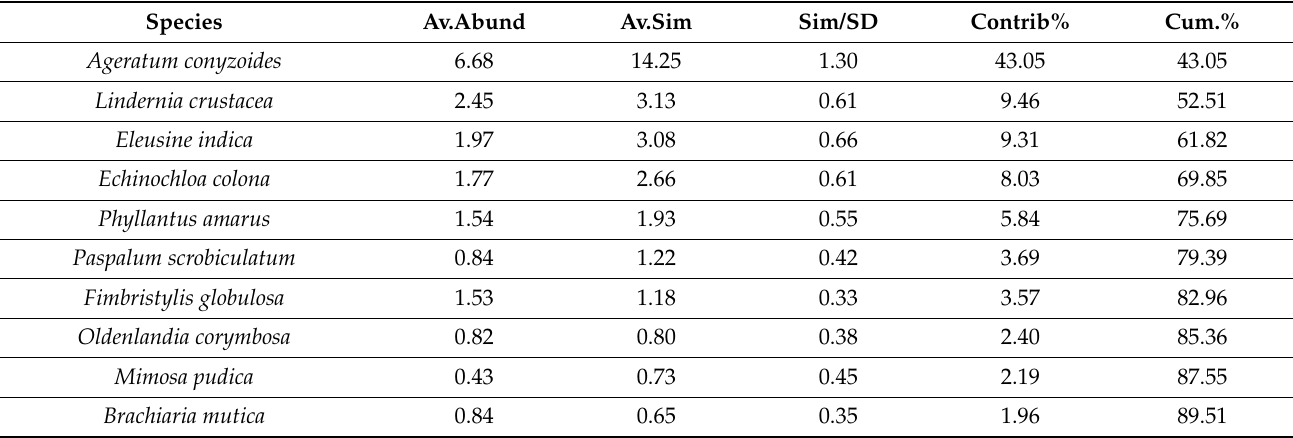
Table 2. Top ten identified weed species on the solar farm in Puchong with Similarity Percentages and Species Contributions.